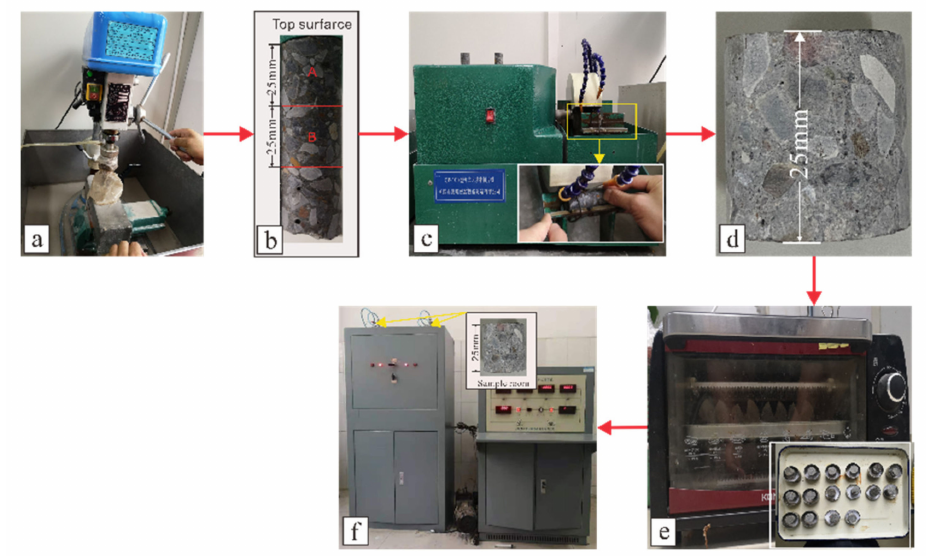
Figure 1. Porosity determination process: corebit, columnar, slicing, sample, mercury injection test ( a – f ,